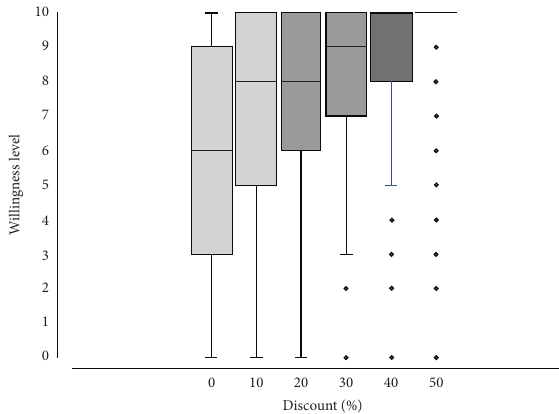
Figure 3: Box plots of passengers’ willingness level under different